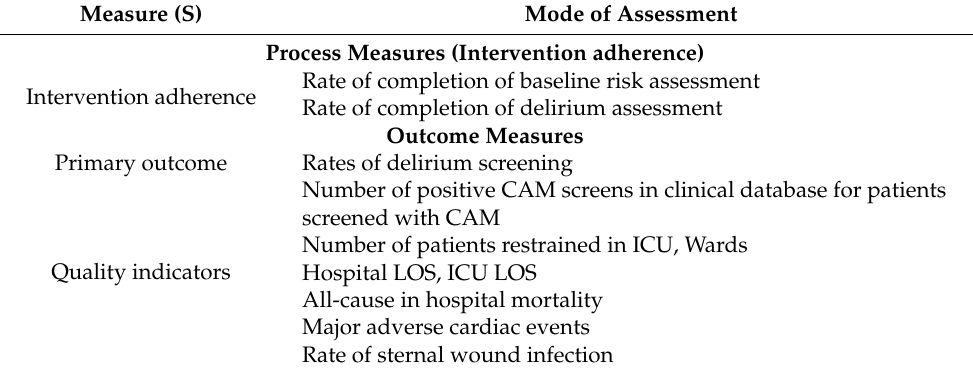
Table 5. Process and Outcome